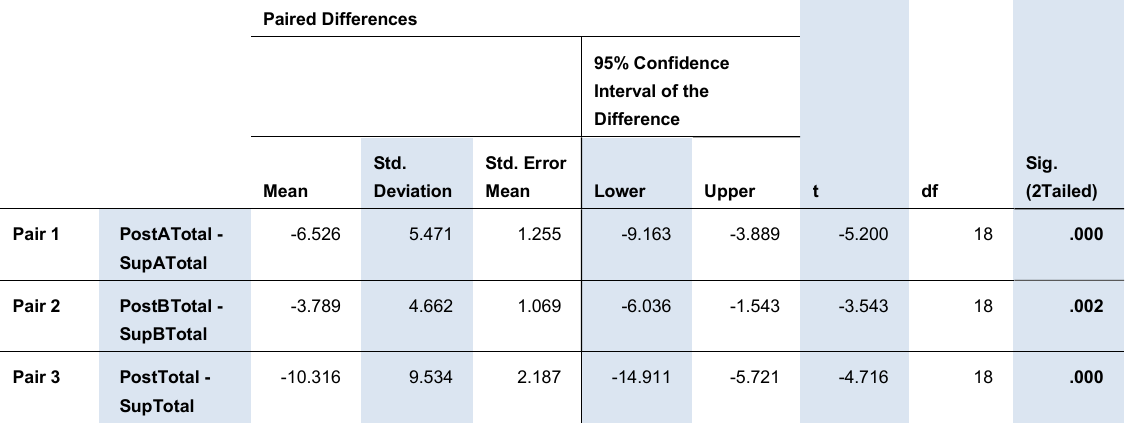
Table 2: Paired Samples Test